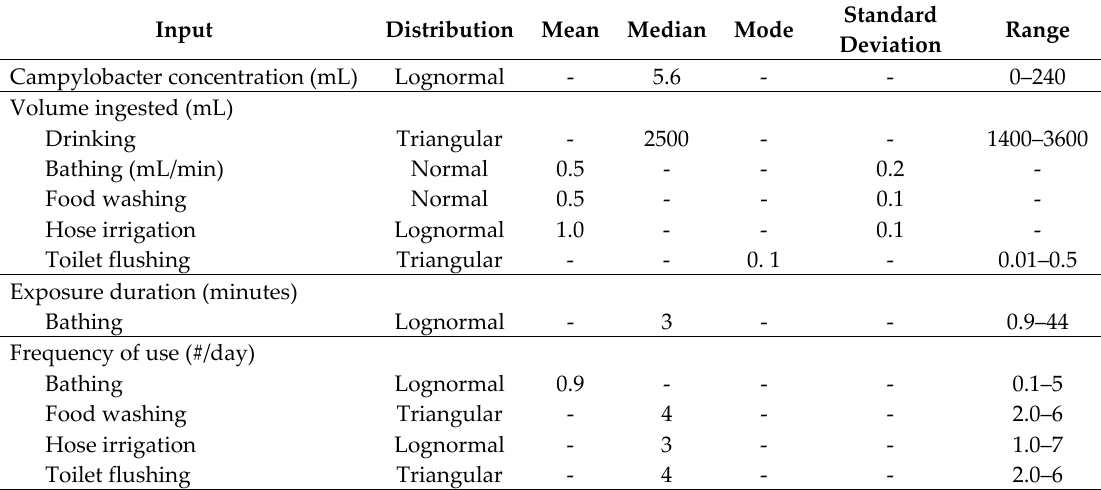
Table 2. Risk input